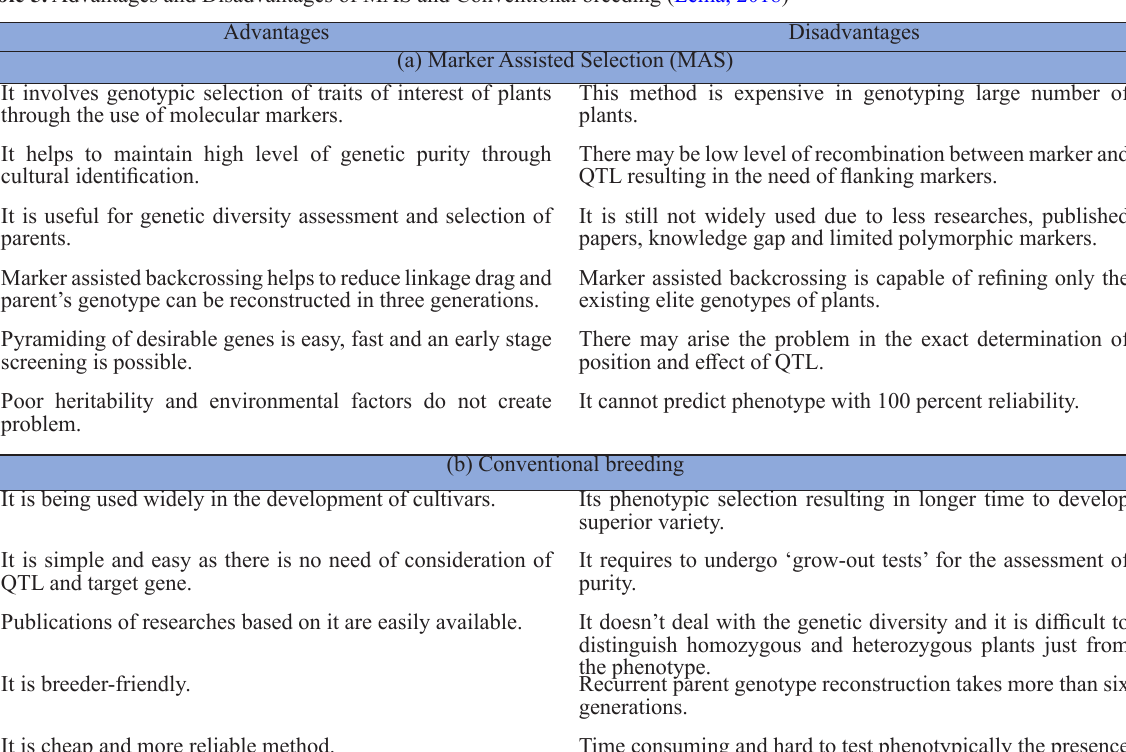
Table 5. Advantages and Disadvantages of MAS and Conventional breeding (Lema,